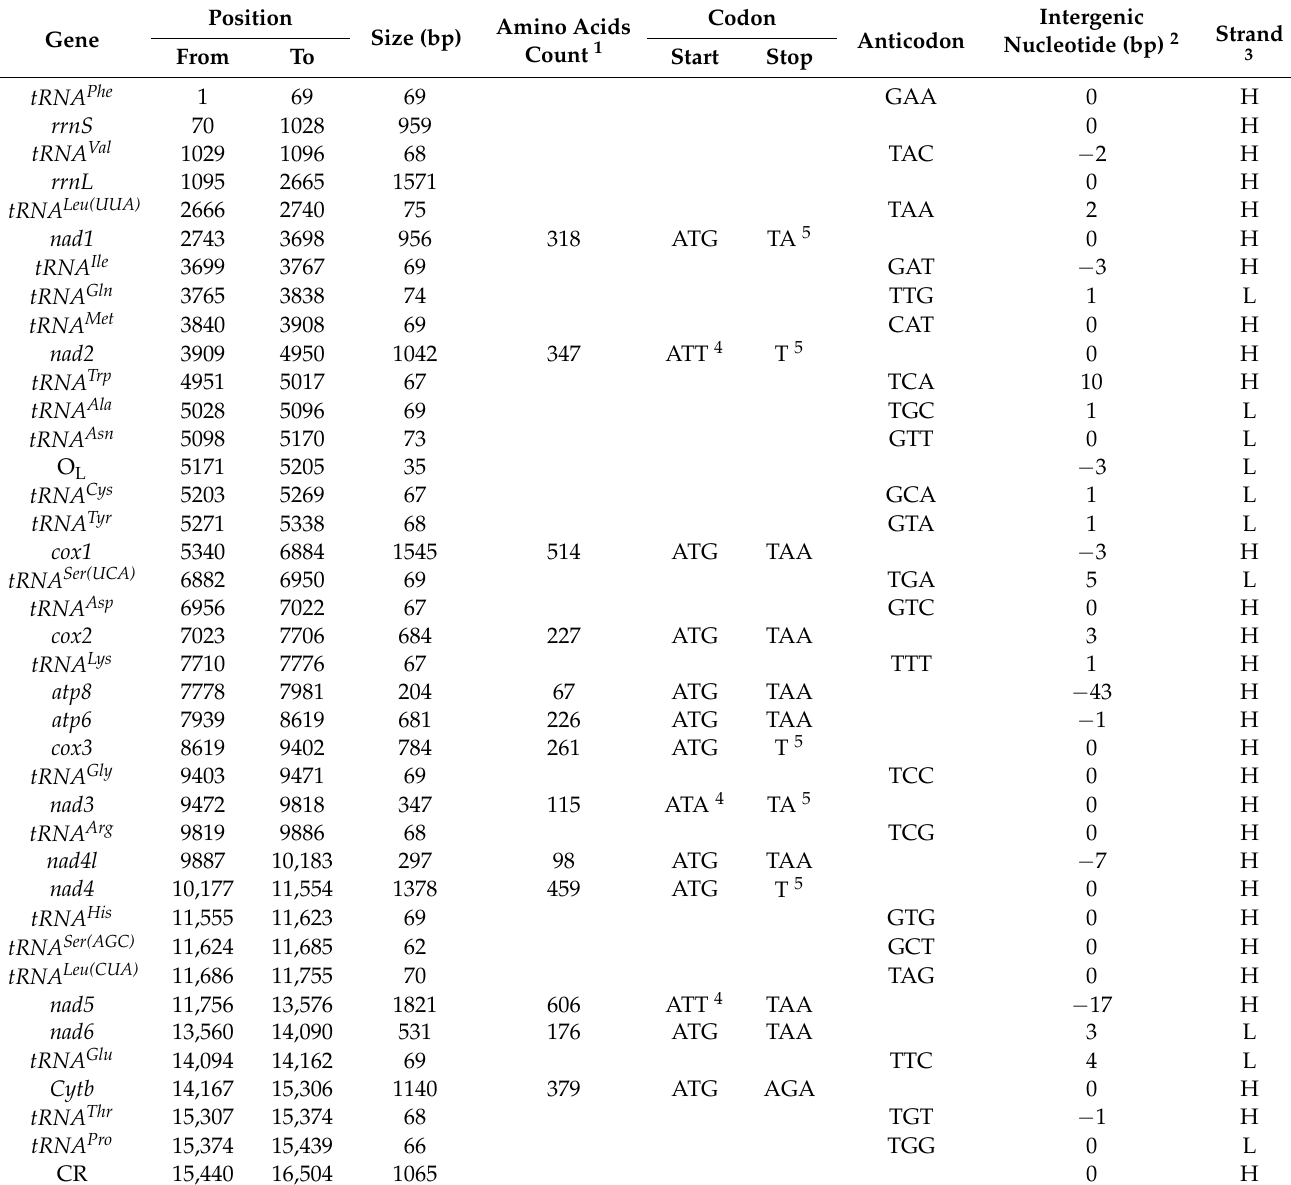
Table 1. Features of the mitochondrial genome of Mustela lutreola